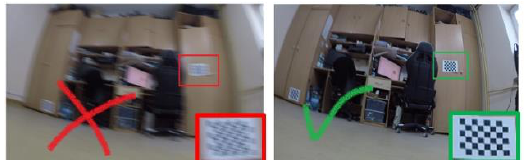
Figure 5. Assessment of the importance of the smear in the acquired image